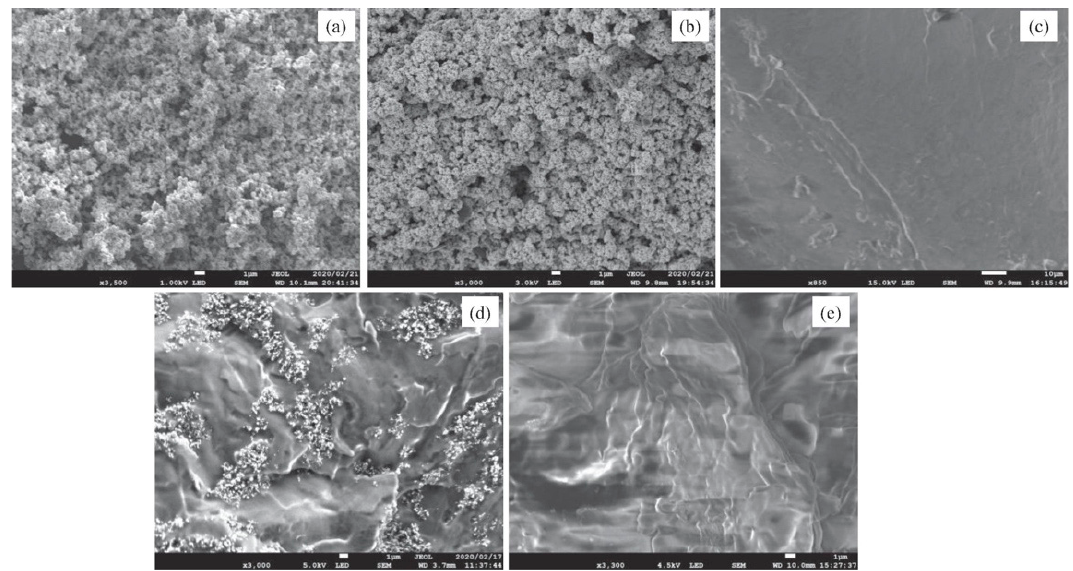
Figure 9. SEM images of ( a ) Silicon carbide, ( b ) Silver, ( c ) Pure paraffin wax, ( d ) Paraffin–SiC composite, and ( e ) Paraffin–Ag composite from Maher et al. (Copyright 2020 Elsevier) [52].